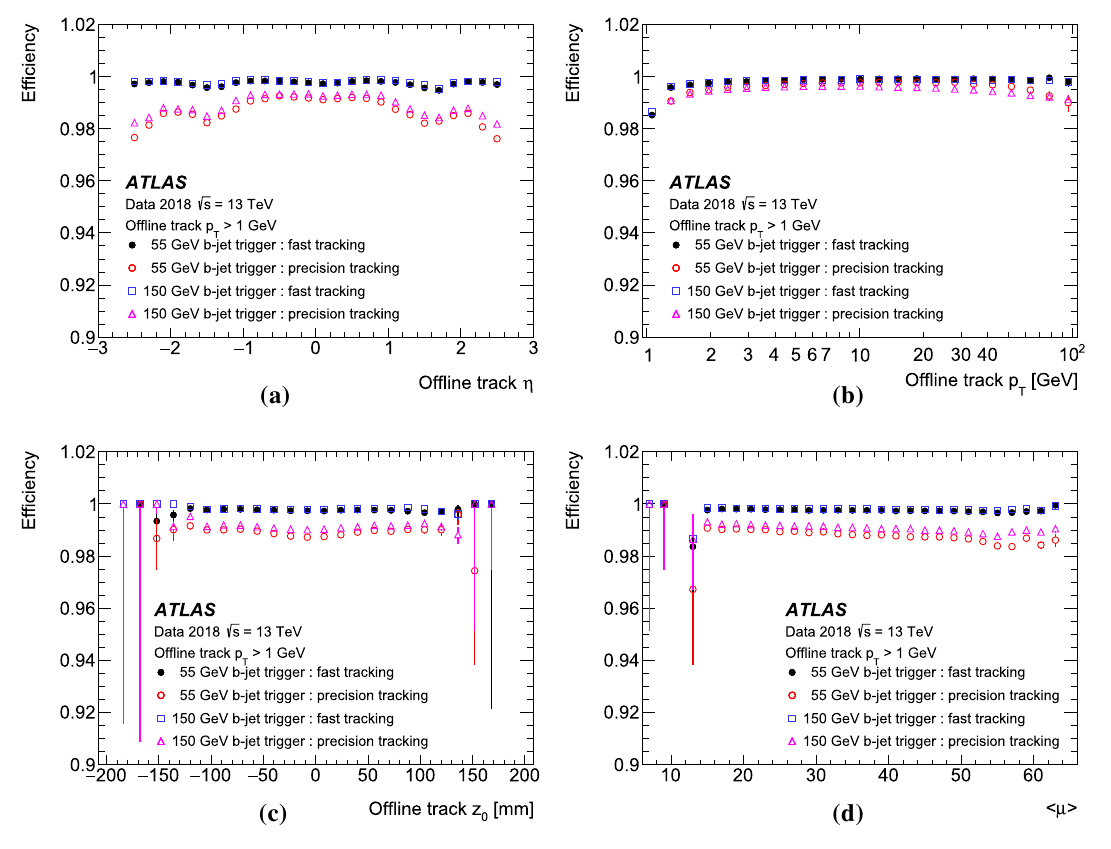
Fig. 36 The b -jet trigger tracking efficiency for tracks with p T > 1 GeV within jets shown as a function of a offline track η , b offline track p T , c offline track z 0 , d the mean number of interactions per bunch crossing. The efficiency is evaluated for the 55 GeV b -jet trigger